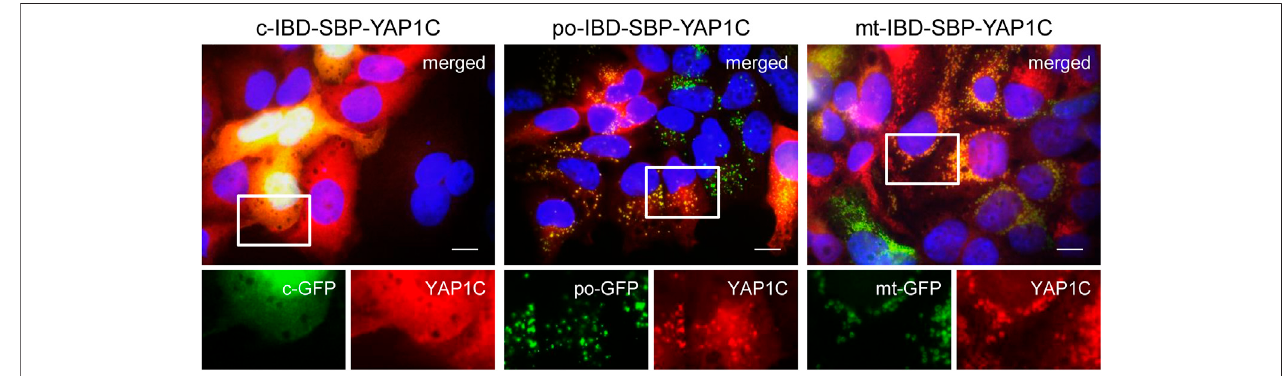
FIGURE 1 | Validation of the subcellular localization of different IBD-SBP-YAP1C fusion proteins in po-DD-DAO Flp-In T-REx 293 cells. Po-DD-DAO Flp-In T-REx 293 cells enriched for expression of c-, po-, or mt-IBD-SBP-YAP1C were transfected with plasmids encoding c-, po-, or mt-roGFP2 (GFP) as marker for the respective cell compartment. After3 days, the cells wereprocessed for immuno fl uorescence microscopyusing rabbitpre-immune serum and goat anti-rabbit secondaryantibody conjugated to Texas Red. Nuclei were counterstained with DAPI. Scale bars, 10 µm. Representative images are shown. The boxed areas in the upper panels are enlarged in the lower